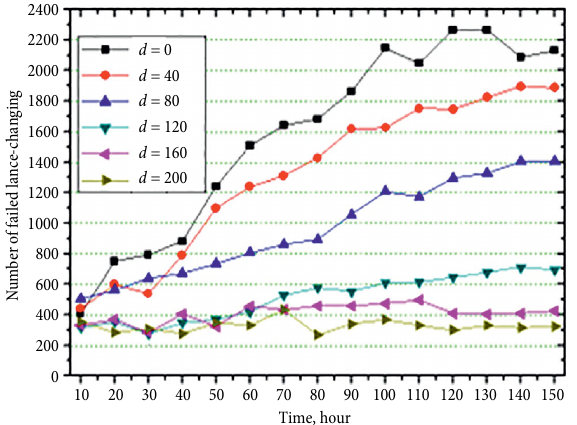
Fig. 10. Numbers of failed lane-changing with VMS in different